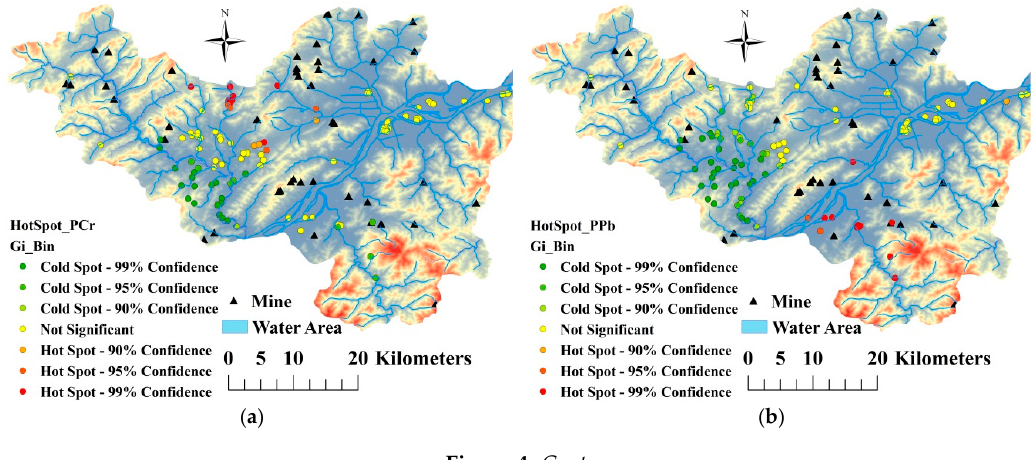
Table 4. Comparison of model accuracy of ordinary kriging (OK) and co-ordinary kriging (COK) for different heavy metals. Element R